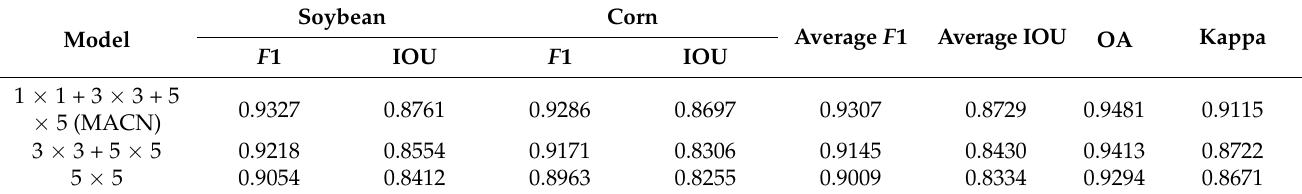
Table 4. Accuracy of crop classification for different numbers of